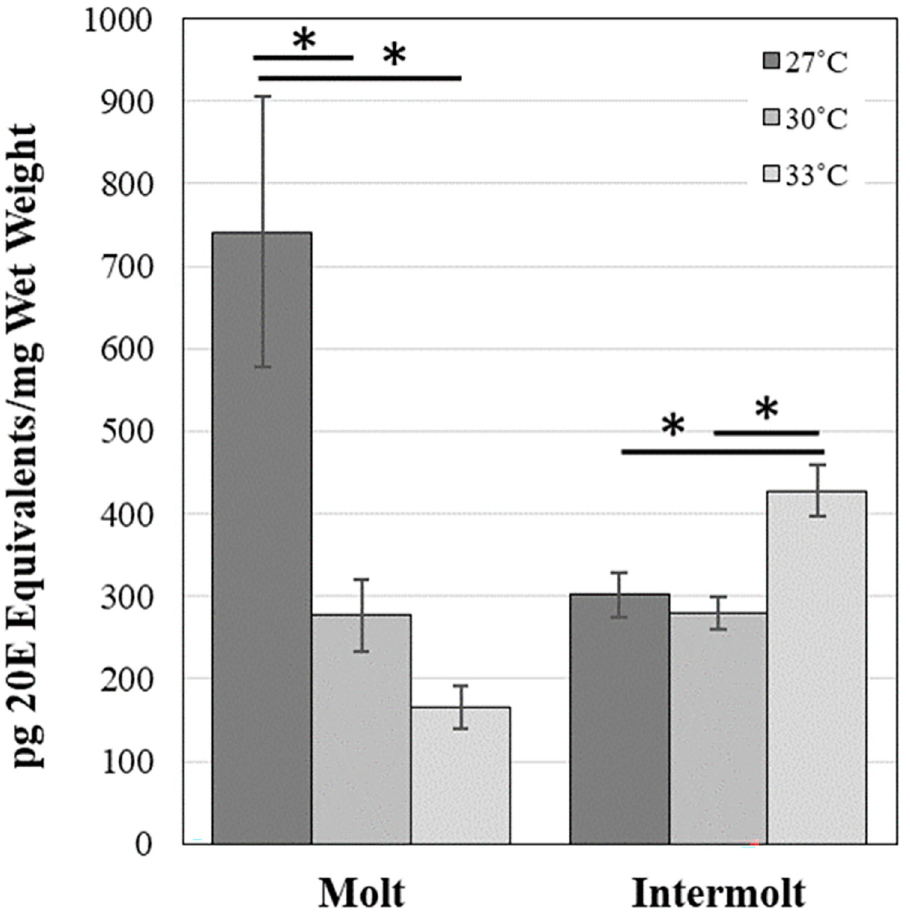
Fig 4. Phase-specific ecdysteroid titers. Average daily ecdysteroid titers from spiderlings reared at 27˚C, 30˚C and 33˚C were determined at two time points: two days prior to the second molt (Molt) and days 2–5 after the second molt (Intermolt). Only families that had spiderlings reared at all three temperatures were used (N = 6 families). Spiderlings were aged relative to the timing of the second molt for each family, at each temperature. Error bars represent standard error. ( � ) indicates a significant difference (p <